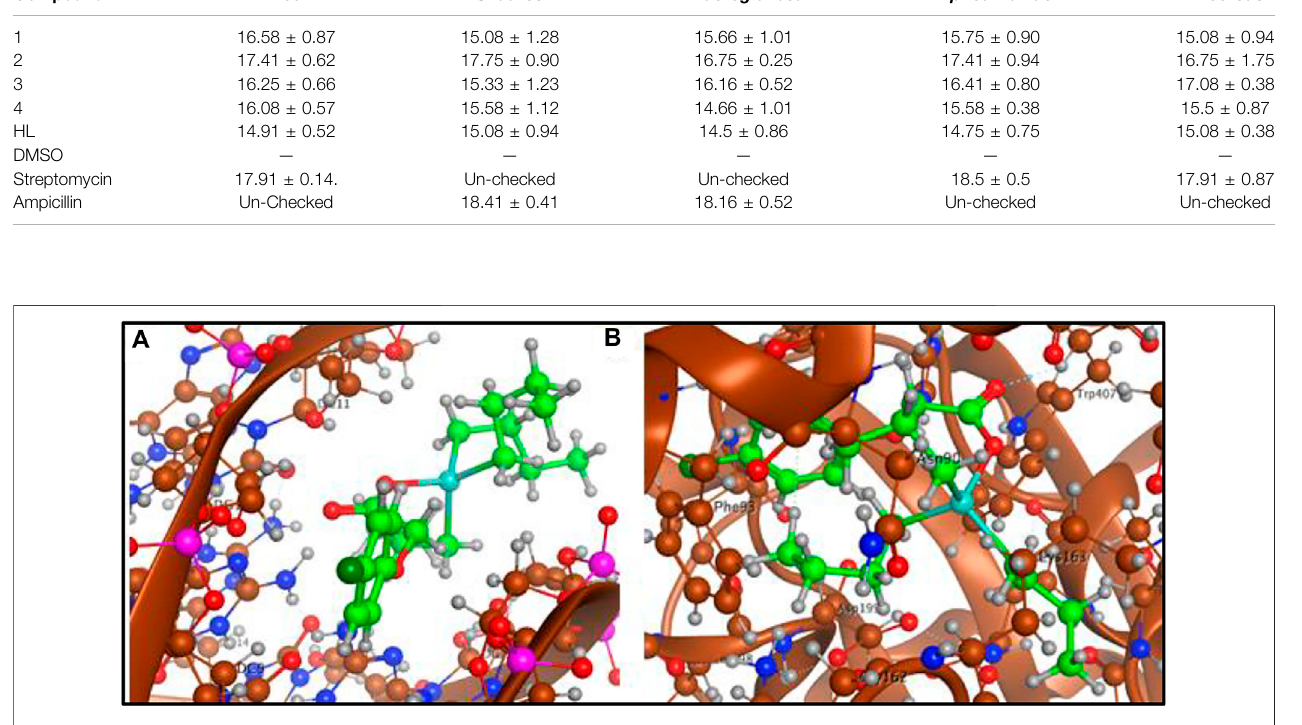
FIGURE 7 | (A) Complex 3 -DNA interaction and (B) Complex 3 -tubulin